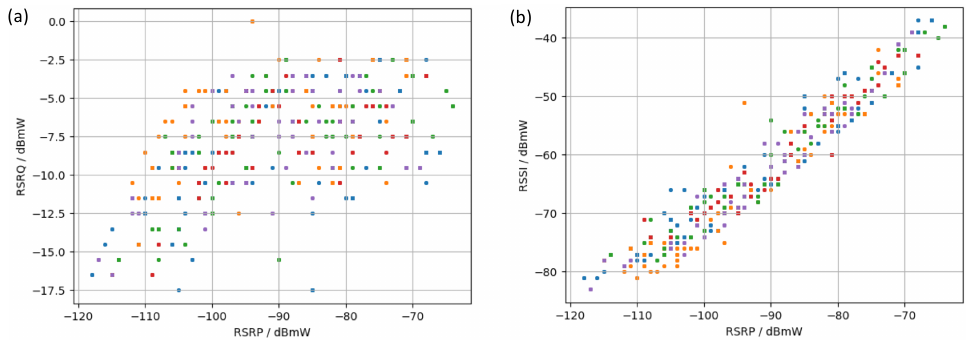
Figure 13. Correlation of ( a ) RSRP and RSRQ; ( b ) RSRP and